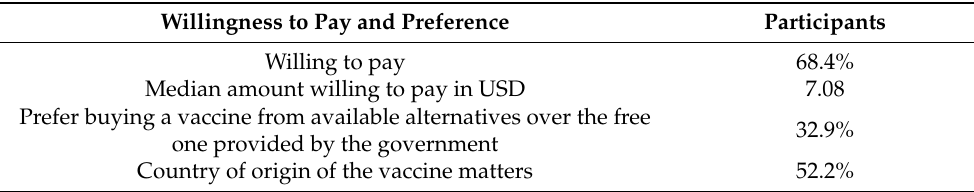
Table 4. Willingness to pay and preference for vaccine against SARS-CoV-2 in